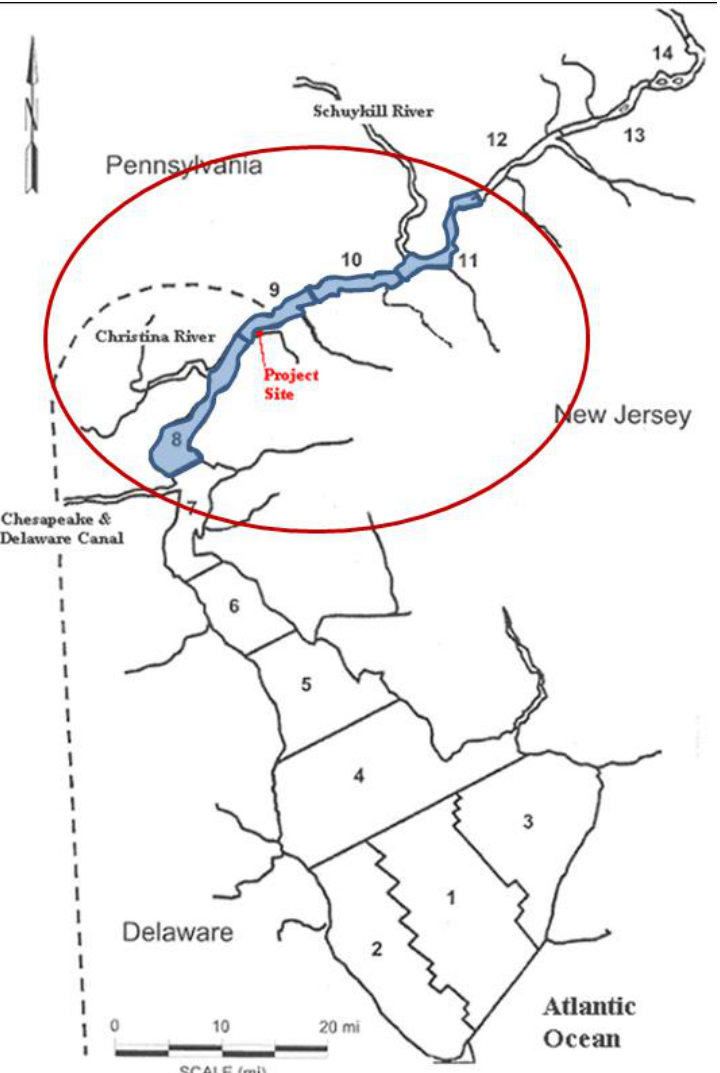
Figure 3. Project location and IP data